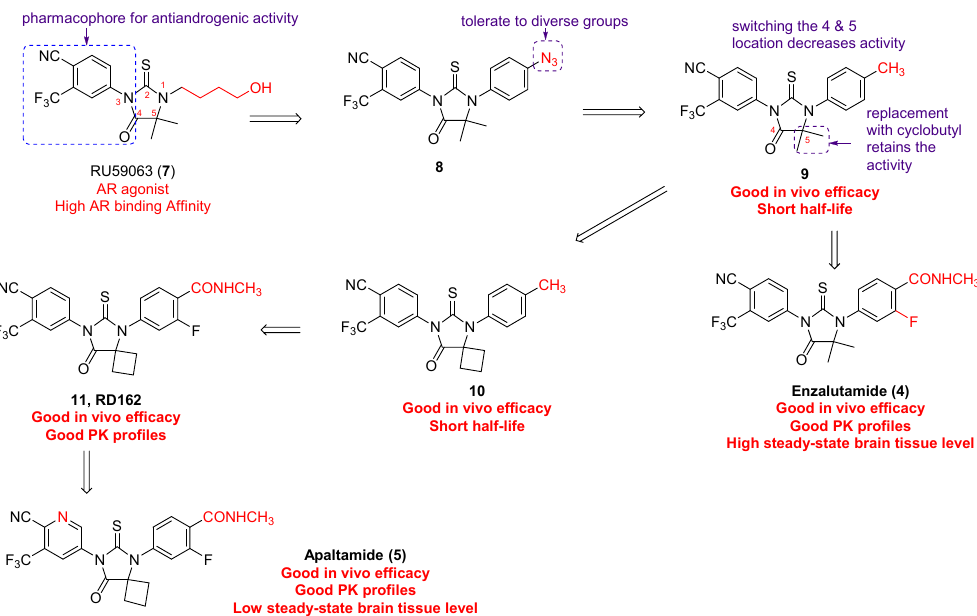
Figure 4. Discovery of enzalutamide and apalutamide.